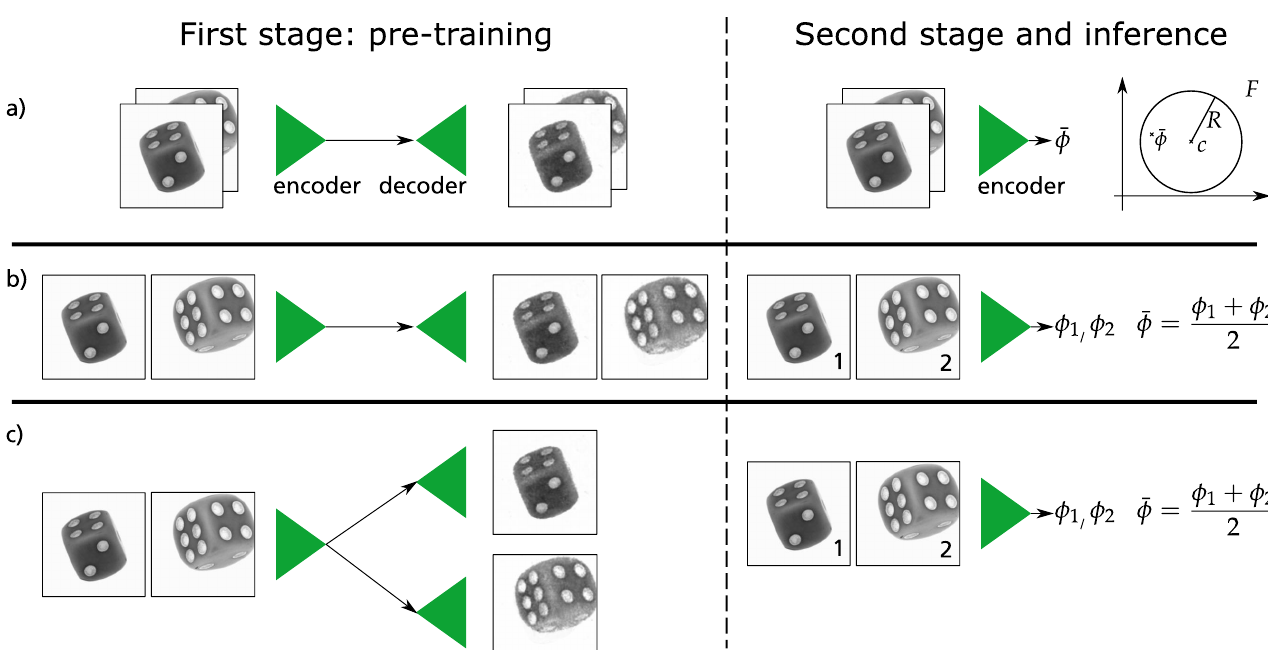
Figure 2. Given two perspectives of the same dice, this figure illustrates the training and fusion techniques that we use in this work. Left column: The first stage comprises of the auto encoder training. Right column: The weights of the encoder are then further trained alone according to Equation (1). ( a ) With an early fusion the two perspectives were stacked channel-wise. Hence the output of the encoder comprises information of both perspectives inherently. ( b , c ) In contrast to that, two outputs were averaged in a late fusion . ( c ) The last row shows the utilization of two